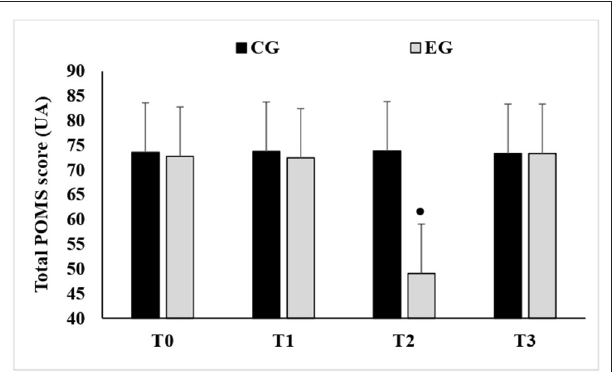
FIGURE 2 | Mean values ± standard deviation (SD) of total scores registered by the Profile of Mood State questionnaire recorded before the start of Ramadan (T0), on the 15th day of Ramadan (T1), at the end of Ramadan (T2) and after Ramadan (T3) in the experimental group (EG, n = 12) and the control group (CG, n = 12). •, Significant difference compared to